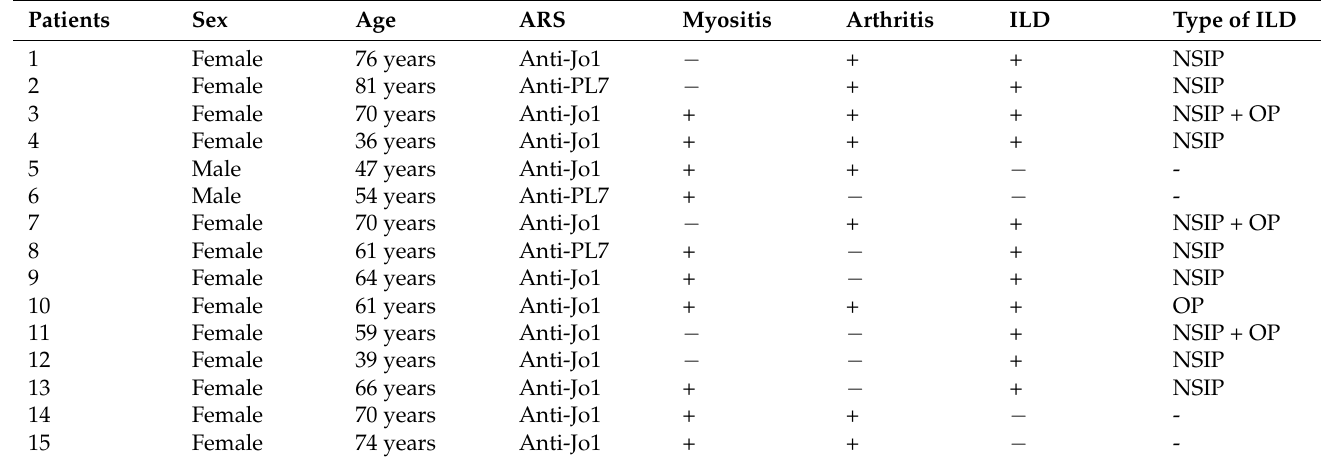
Table 1. Demographic and clinical data of study